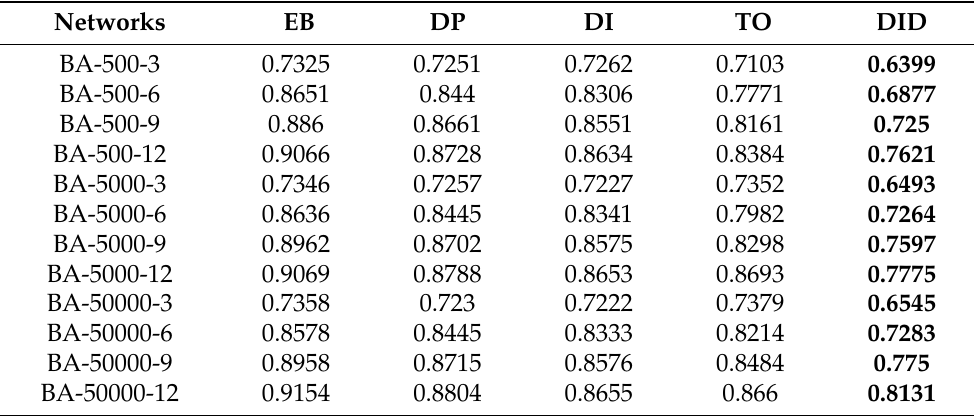
Table 6. The R of DID and classic algorithms in the BA